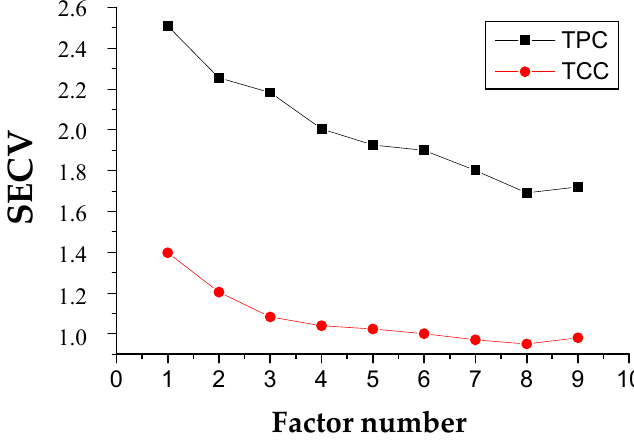
Figure 3. Plot of standard error of cross-validation (SECV) vs. the different number of factors included in the cross-validation of the modified partial least model for Total phenolic content (TPC) and total carotenoid content (TCC).